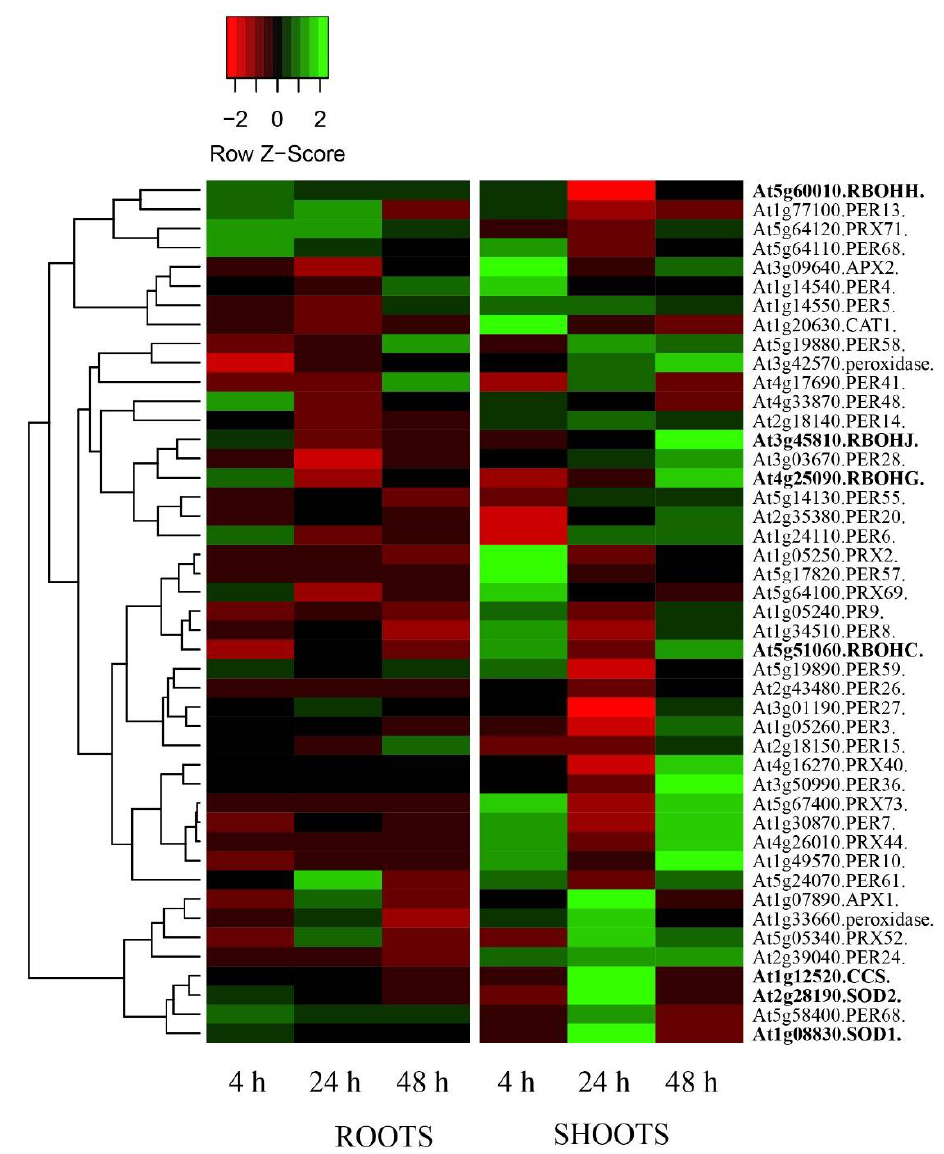
Figure 3. Gene expression fold change heatmap calculated with a Pearson distance and average linkage method from genes coding for ROS-scavenging enzymes selected from Supplementary Table S2 (see Supplementary Table S4). The heatmap was generated by using a single linkage clustering method and Pearson distance measuring method. Gene coding for ROS-producing enzymes are evidenced in boldface. Downregulated genes are marked in red-shaded colors, whereas upregulation is evidenced by different shades of green.